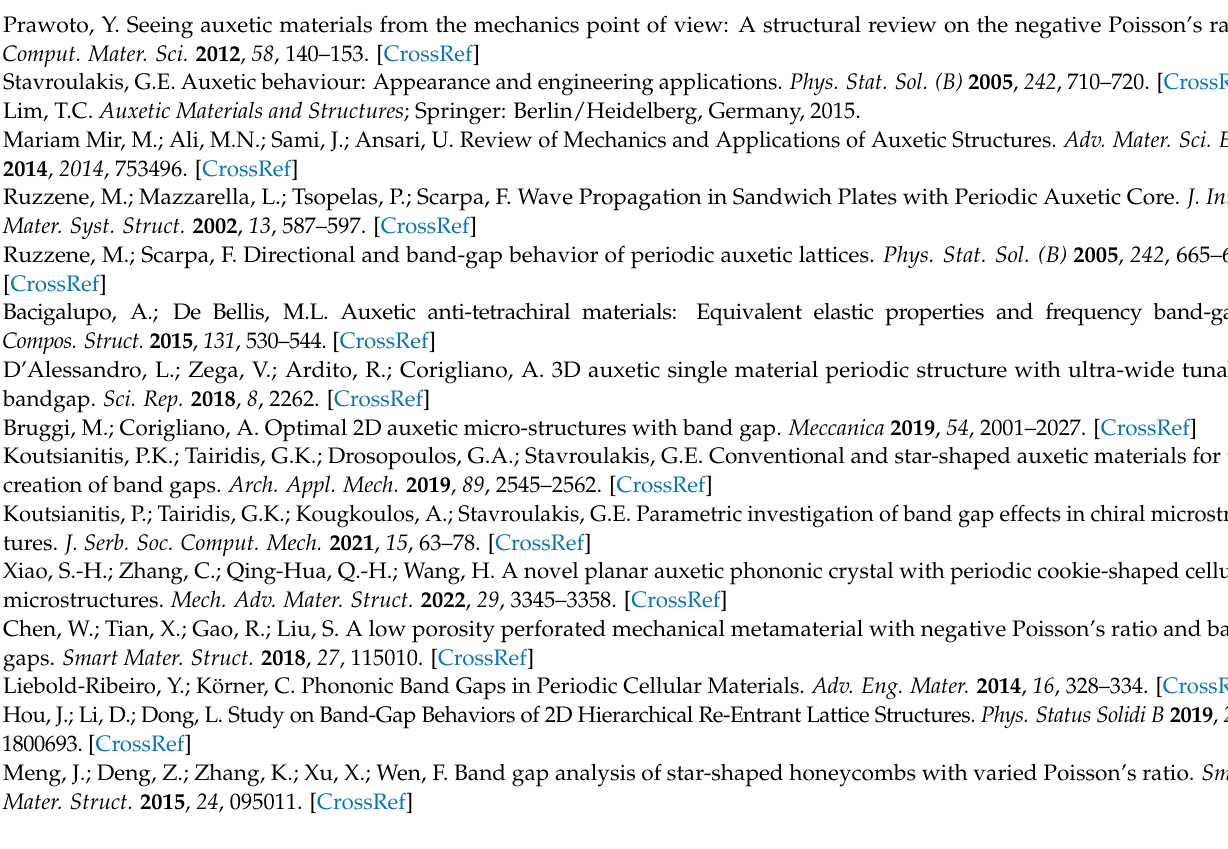
Finally, the production cost should be considered for a specific application. By using auxetic shapes with round corners, the stress concentrations have been reduced and the longer life of the component is guaranteed. Experimental investigation is planned in order to demonstrate this